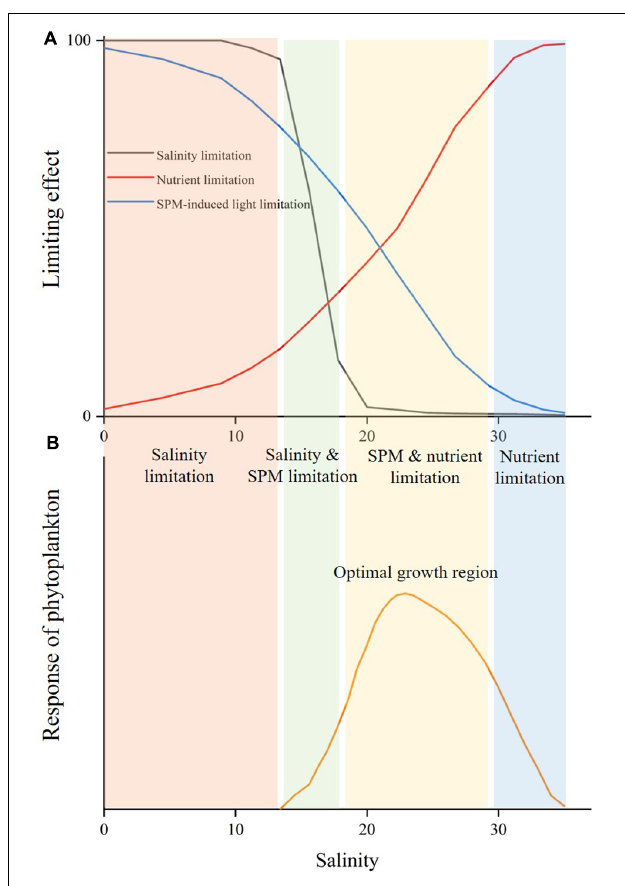
FIGURE 10 | Schematic of the changes in limiting effects (A) and the growth response of marine phytoplankton (B) along the salinity gradient in estuary